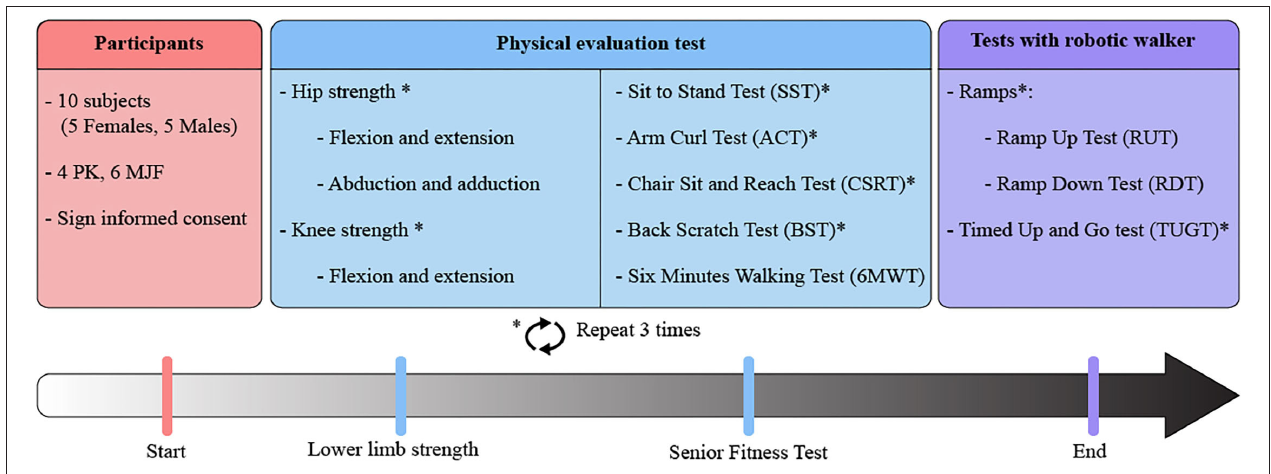
FIGURE 4 | Summary of the protocol and experimental tests performed by the older adults to evaluate their performance within the study.